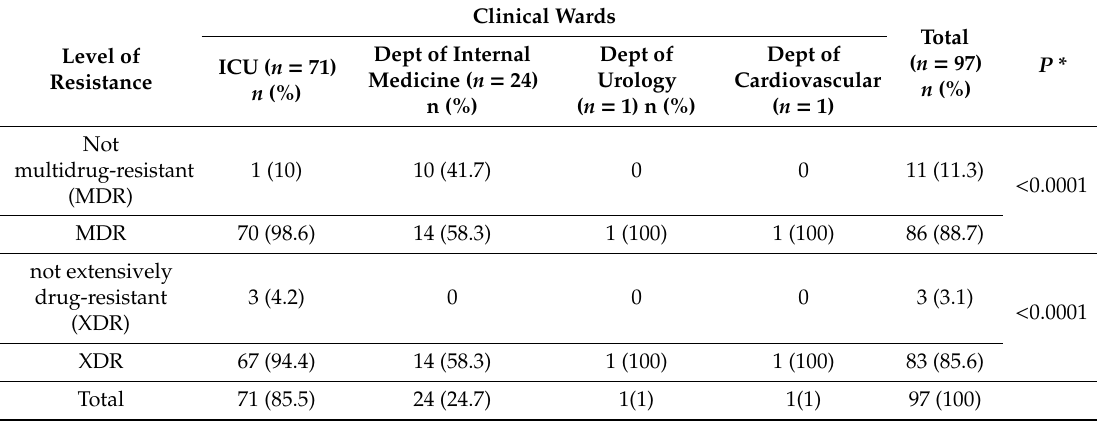
Table 2. Multidrug-resistant classification of the 97 viable Ab strains according to clinical